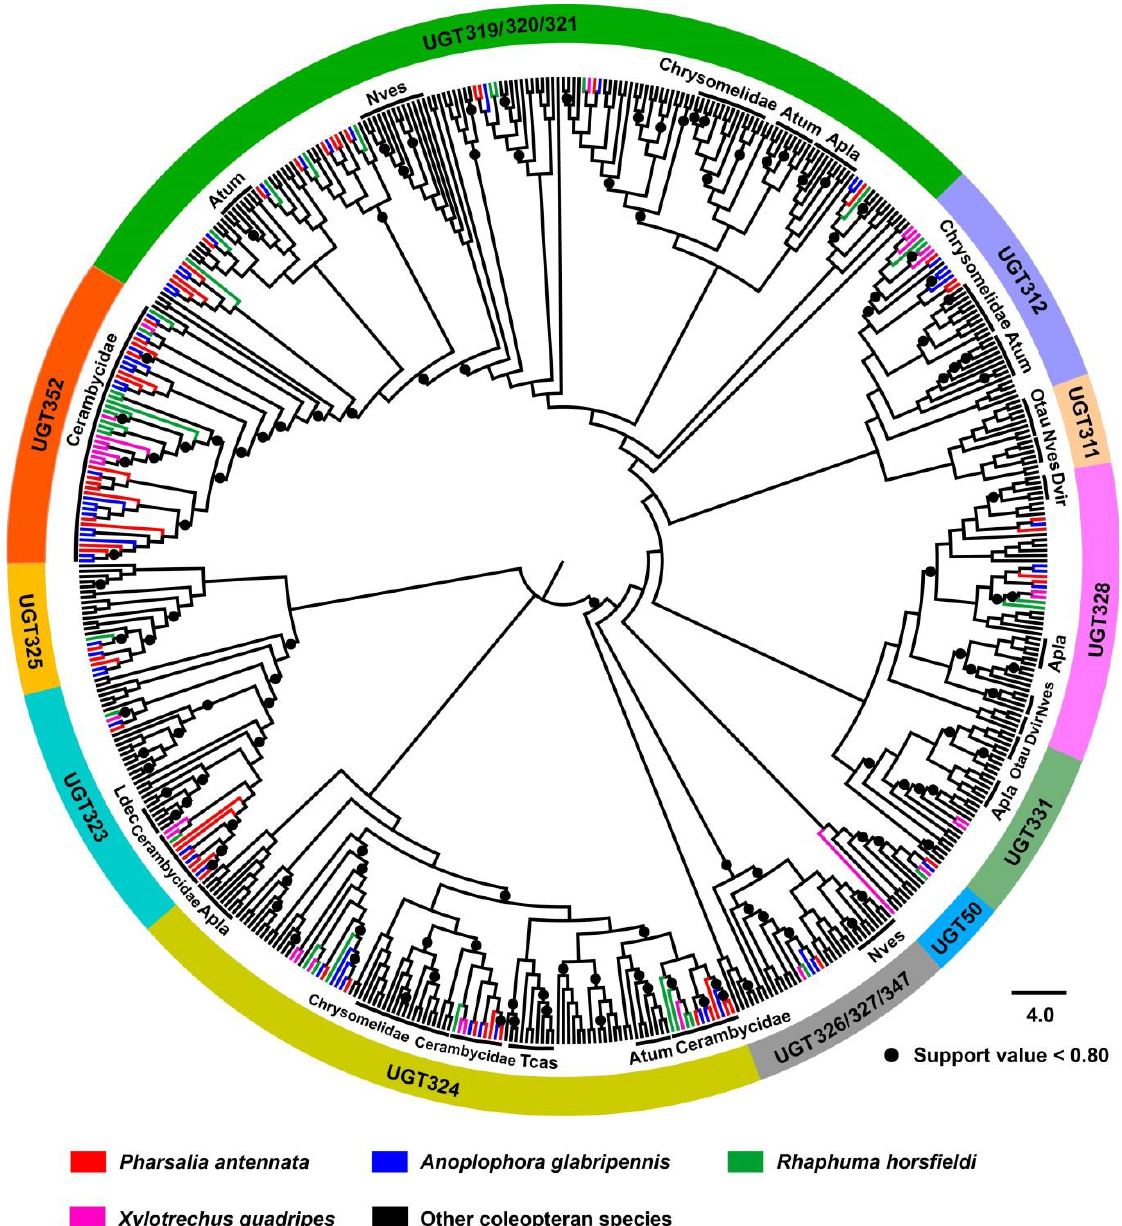
Figure 2. Phylogenetic relationship of coleopteran UGTs. The tree was constructed by FastTree v2.1.11, based on an aligned protein sequence of UGTs in 15 coleopteran species. Support values were computed with SH-like 1000 support. Species-specific color patterns of UGTs are presented for four cerambycid species, and the UGTs of other species are highlighted in black. Atum: Aethina tumida ; Apla: Agrilus planipennis ; Dvir: Diabrotica virgifera virgifera ; Ldec: Leptinotarsa decemlineata ; Nves: Nicrophorus vespilloides ; Otau: Onthophagus taurus , Tcas: Tribolium castaneum . Apart from the two clades UGT311 and UGT331, the nine clades possessed at least one member of PantUGTs in P. antennata . Of these, UGT352 was specific to the Cerambycidae and had 15 P. antennata UGTs, representing the most relatives among the nine clades. Both UGT319/320/321 and UGT324 harbored comparable gene numbers, with 14 and 11 relatives, respectively. A highly conserved UGT50 subfamily was composed of one singleton from each species, including P. antennata , in which 11 full-length UGT50 orthologs shared an average 72.88% amino acid identity with particularly high conservation